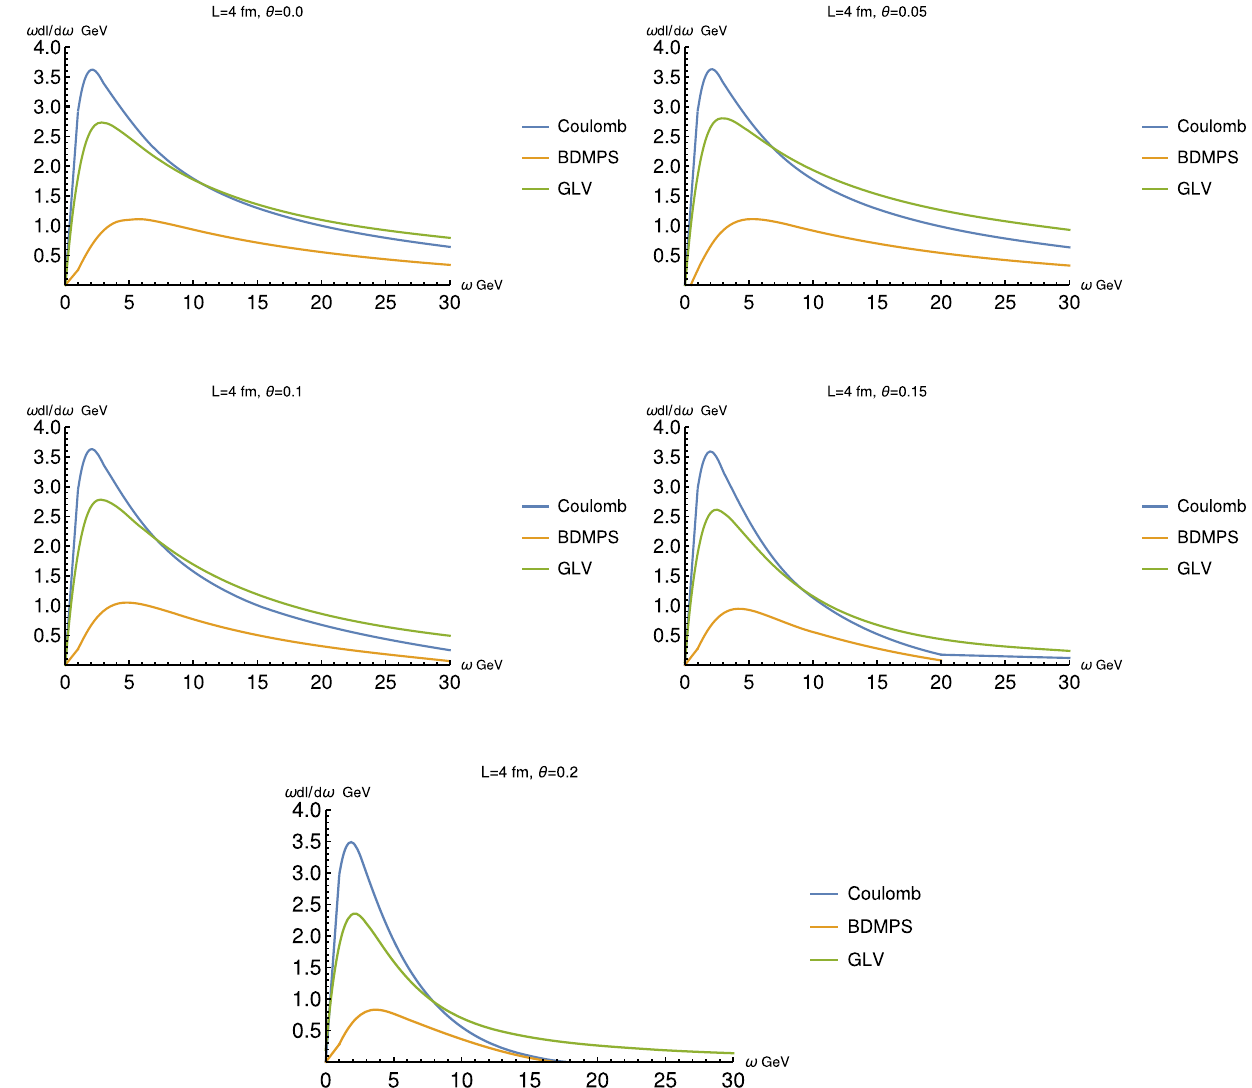
means the expression for soft gluon emission in harmonic oscillator approximation, and Coulomb means the full result including Coulomb logarithms (Moliere